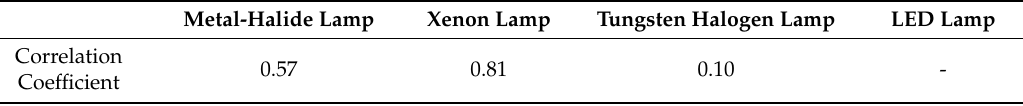
Table 5. The correlation between the spectral radiances of lamps and skylight.